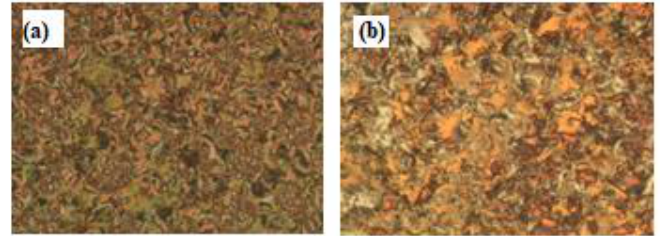
Figure 6. Graphical DSC transitions of 2:1 SMHB complexes, I/An .